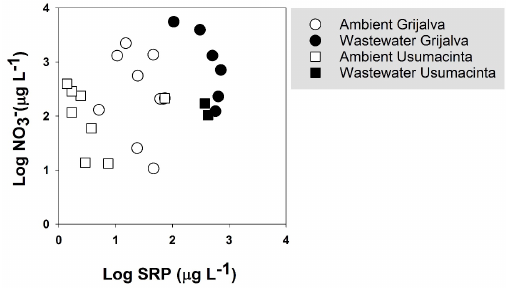
Figure 2. Relationship between nitrate (NO 3- ) and soluble reactive phosphorus (SRP) concentrations from the water column (ambient; white) and in wastewater discharge (wastewater; black) entering the Grijalva ( ○ ) and Usumacinta ( □ ) basins. SRP concentrations in subsidies are greater than ambient water SRP, and the SRP concentrations are much less variable than the nitrate concentrations in wastewater. Samples were collected (Lamberti & Hauer, 2017) and analyzed (Rice et al., 2017) using standard